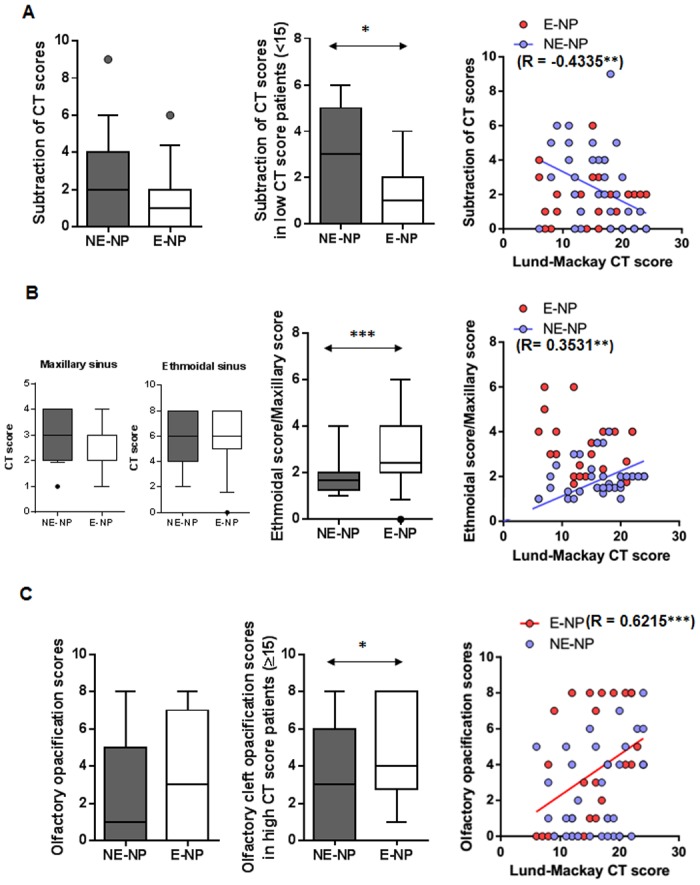
Comparison of clinical CT findings and correlation between Lund-MacKay CT score/clinical CT findings in different endotypes of CRSwNP, including (A) subtraction of CT scores, (B) olfactory opacification scores, and (C) ethmoidal scores and maxillary scores (*p<0.05, **p<0.01, and ***p<0.001).Data represent medians (IQR). E-NP, eosinophilic nasal polyp; NE-NP, non-eosinophilic nasal polyp.